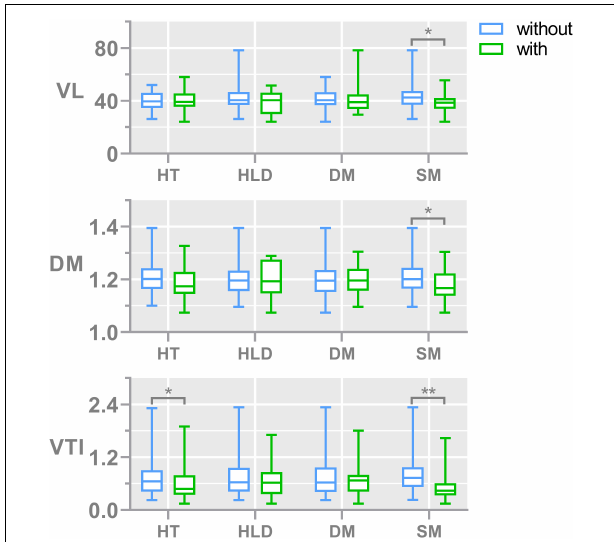
FIGURE 3 | Bar plots show the comparisons of vessel morphological measures, including the median of DM, VTI, and VL, between subjects with and without different risk factors. The numbers of subjects with and without hypertension are 51 and 74, respectively; the numbers of subjects with and without diabetes are 19 and 106, respectively; the numbers of subjects with and without hyperlipidemia are 18 and 107, respectively; the numbers of subjects with and without smoking are 36 and 89, respectively. The median number of LSA counts in all subjects was 8. DM, median distance metric; VTI, median vessel tortuosity index; VL, median vessel length; HT, hypertension; HLD, hyperlipidemia; DIA, diabetes mellitus; and SM,